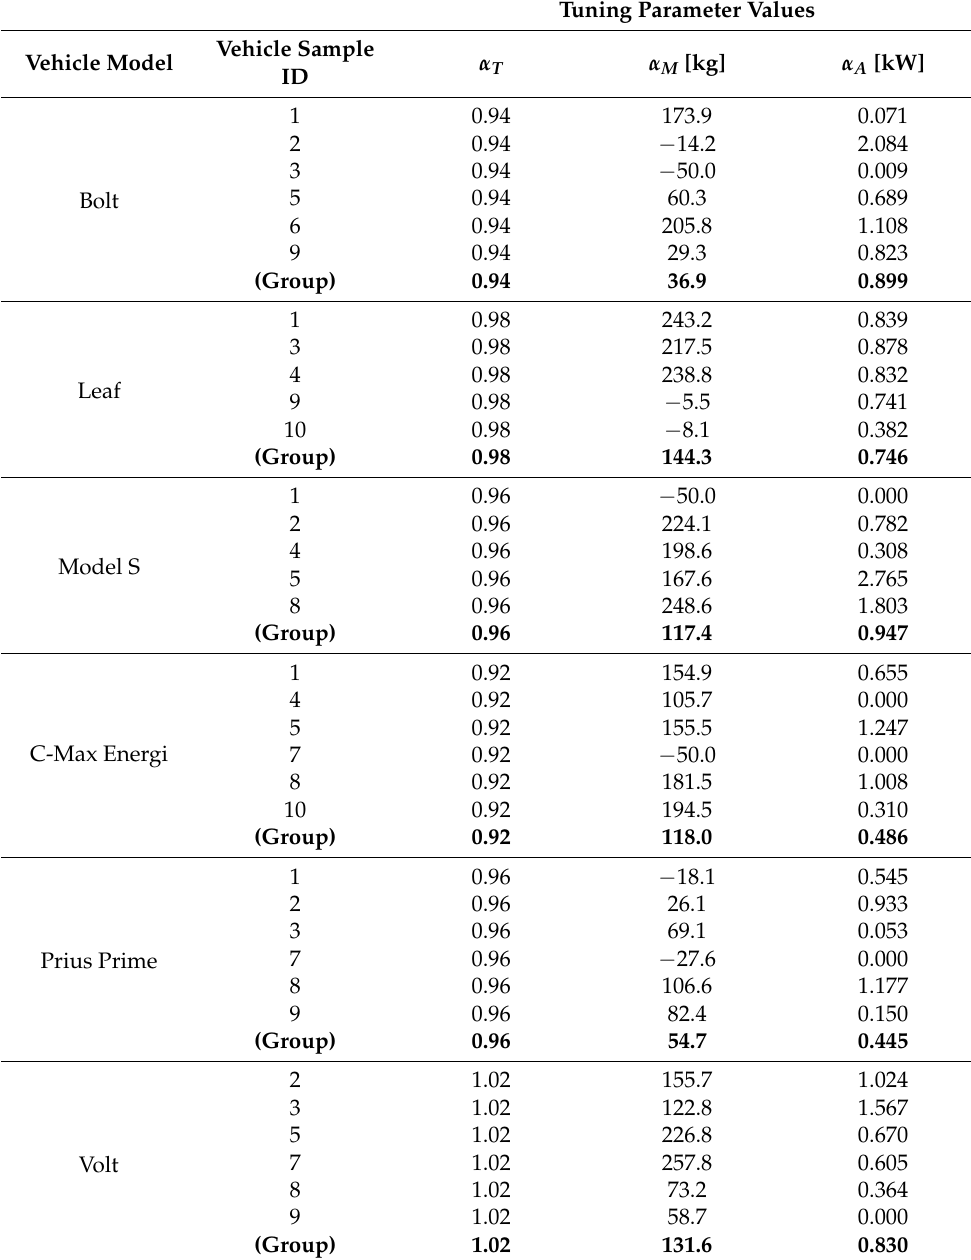
Tuning Parameter Values